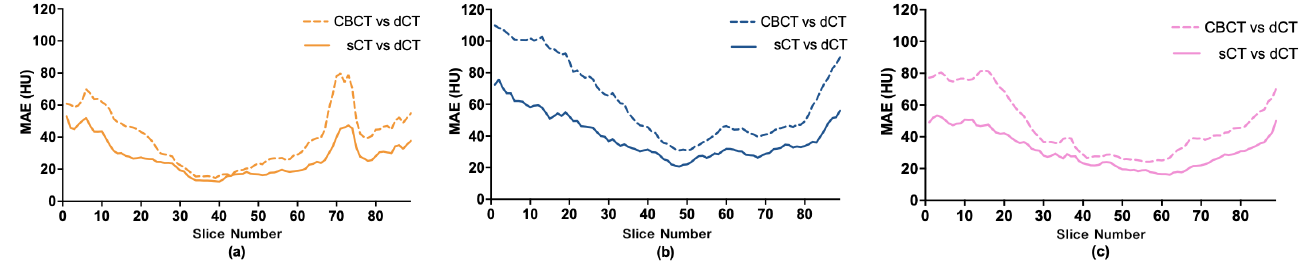
Figure 12. Comparison of sCT with dCT and CBCT with dCT using MAE for each slice on ( a ) Patient 1 ( b ) Patient 5 ( c ) and Patient